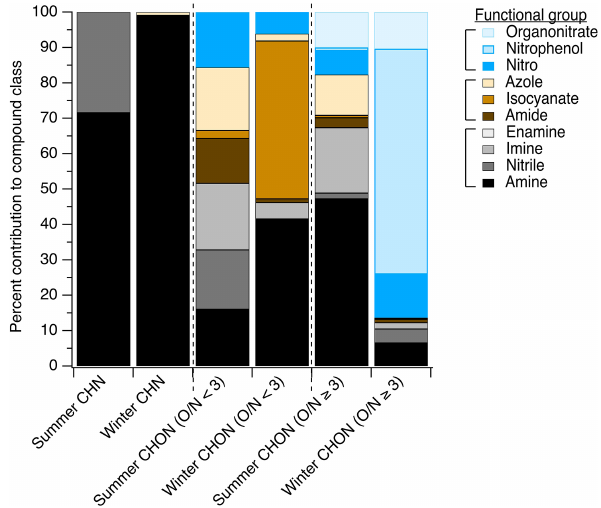
Figure 4. The distribution of functional groups in particle-phase nitrogen-containing compounds measured via LC-ESI-MS/MS. The breakdown of CHN, CHON (O / N < 3), and CHON (O / N ≥ 3) compounds is shown as a function of contributions of each func- tional group to ion abundance, with possible NO z species shown in blue shades, fully reduced nitrogen-containing groups shown in black/grey shades, and groups containing both oxygen and nitro- gen where the nitrogen atom itself is not oxidized shown in brown shades. The same data tallied by occurrence are shown in Fig. S6 for comparison. Figures S7 and S8 show the functional group distribu- tion for CHNS and CHONS compound classes tallied by abundance and by occurrence,